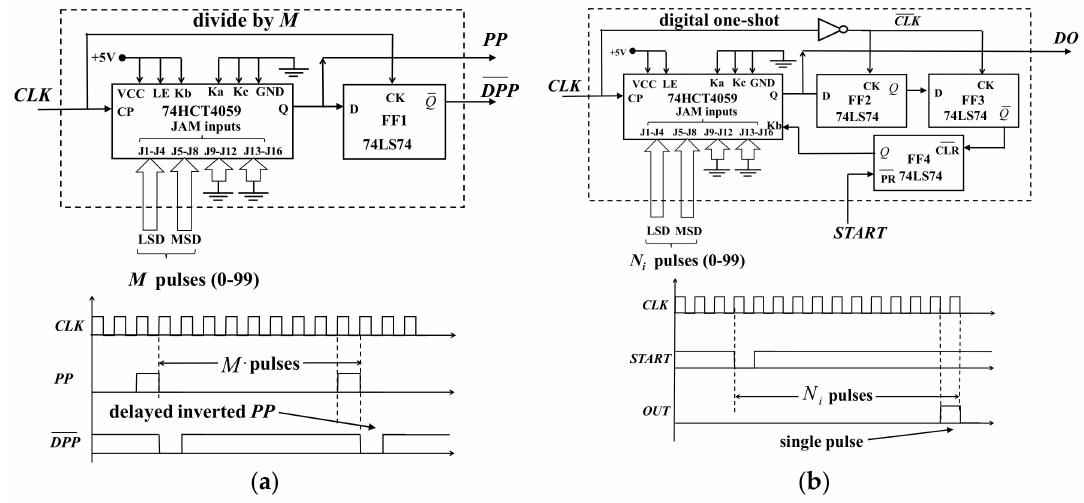
Figure 5. ( a ) Schematic and timing diagram of the period module used as period pulse generator. The period module produces a repeating pulse every N i input pulses. ( b ) Schematic and timing diagram of digital one-shot module. The digital one-shot produces a single delayed pulse after the START signal goes